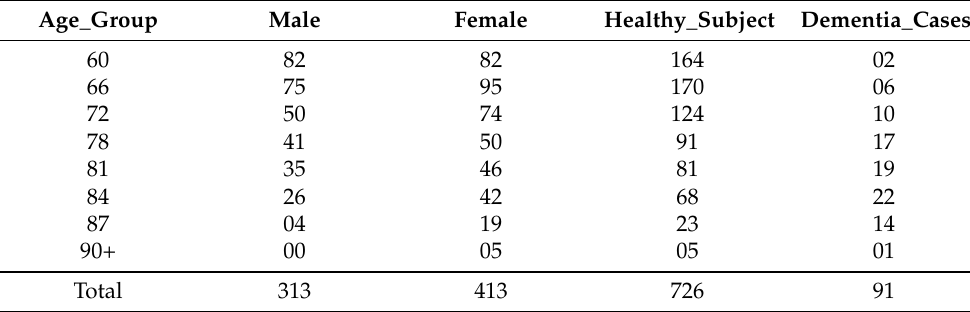
Table 1. Demographic overview of the data